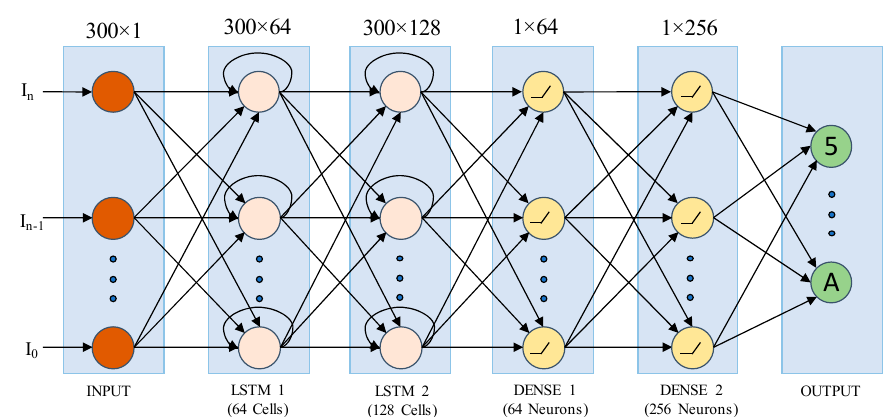
Figure 6. Network diagram of the proposed LSTM network indicating the input, output and hidden layers. Here I 0 and I n is the first and last point for an individual trajectory, respectively. There are two LSTM and dense layer with multiple neurons. The output layer is the result of the model.